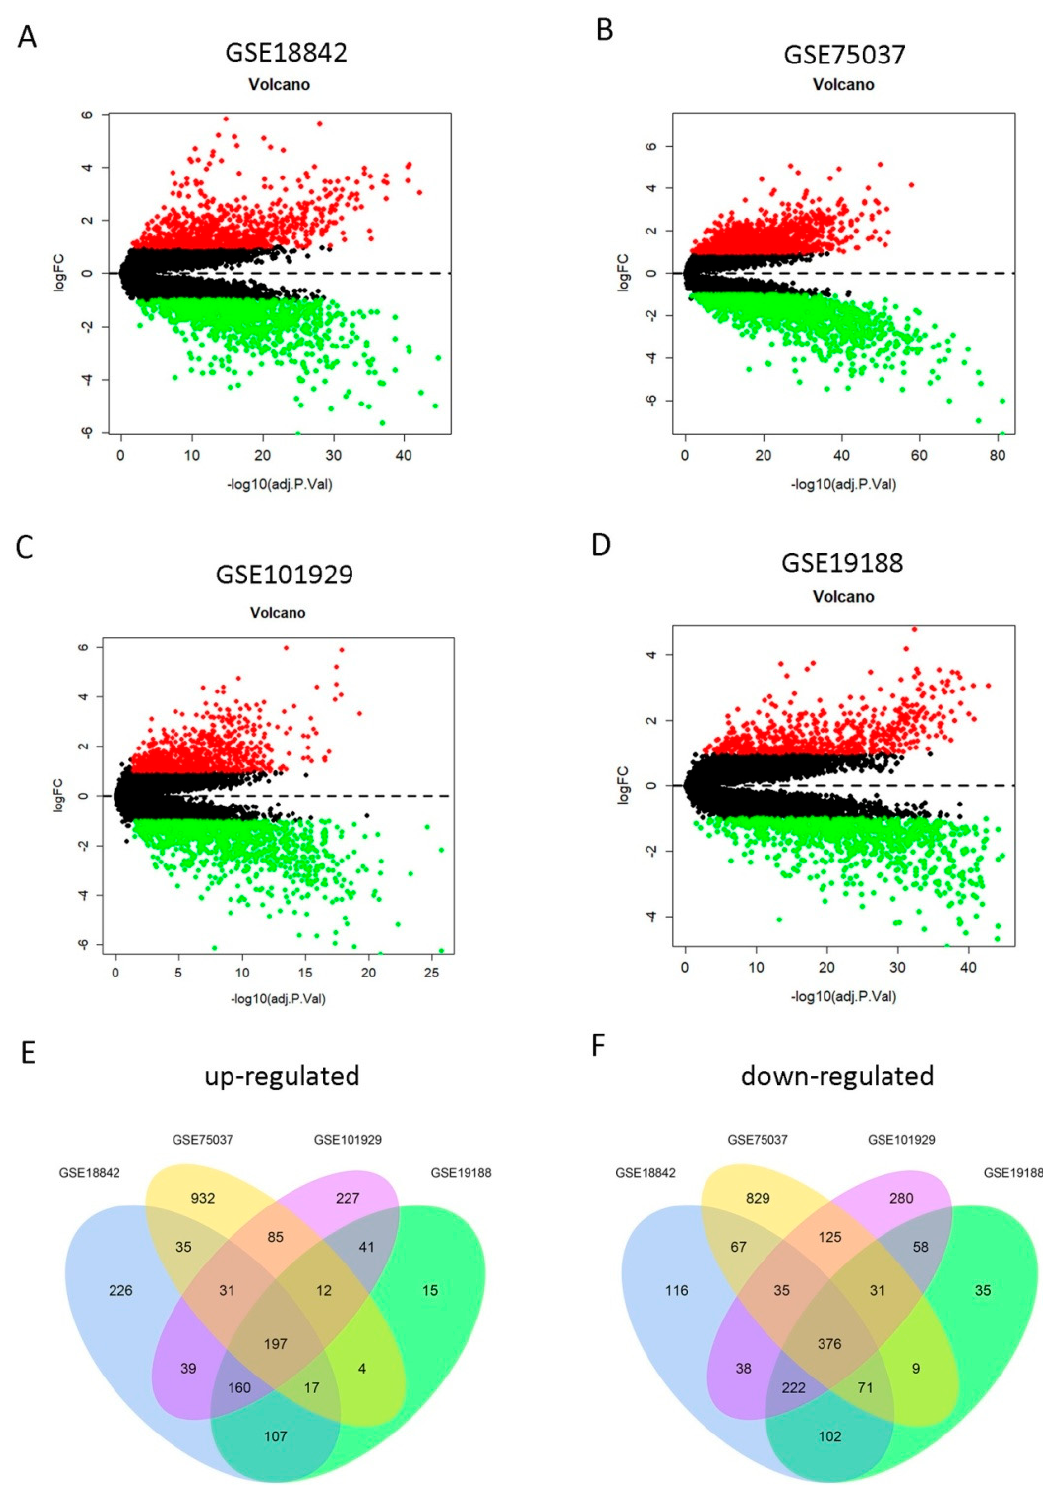
Figure 2. Identification of di ff erentially expressed genes (DEGs) from four Gene Expression Omnibus (GEO) profiles. ( A – D ) Upregulated (redcolored spots) and downregulated (greencolored spots) DEGs in lung adenocarcinoma (LUAD) (compared to normal lung tissues) screened from the GEO profile GSE18842 ( A ), GSE75037 ( B ), GSE101929( C ), and GSE19188 ( D ). ( E – F ) A total of 197 upregulated ( E ) and 376 downregulated ( F ) DEGs were shared among the four GEO expression profiles.